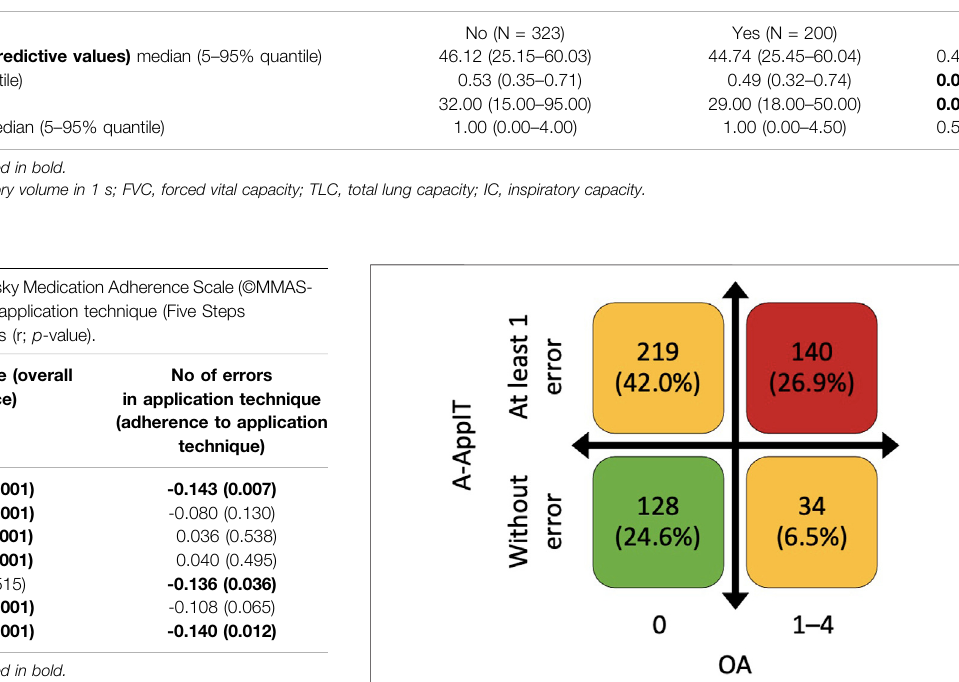
FIGURE 2 | Combination of overall adherence (OA) based on Morisky Medication Adherence Scale (©MMAS-4) and adherence to application technique (A-ApplT) based on Five Steps Assessment. OA — 0 points means the highest adherence, and 4 points means the lowest adherence. A-ApplT – numbers of errors in all inhalation systems